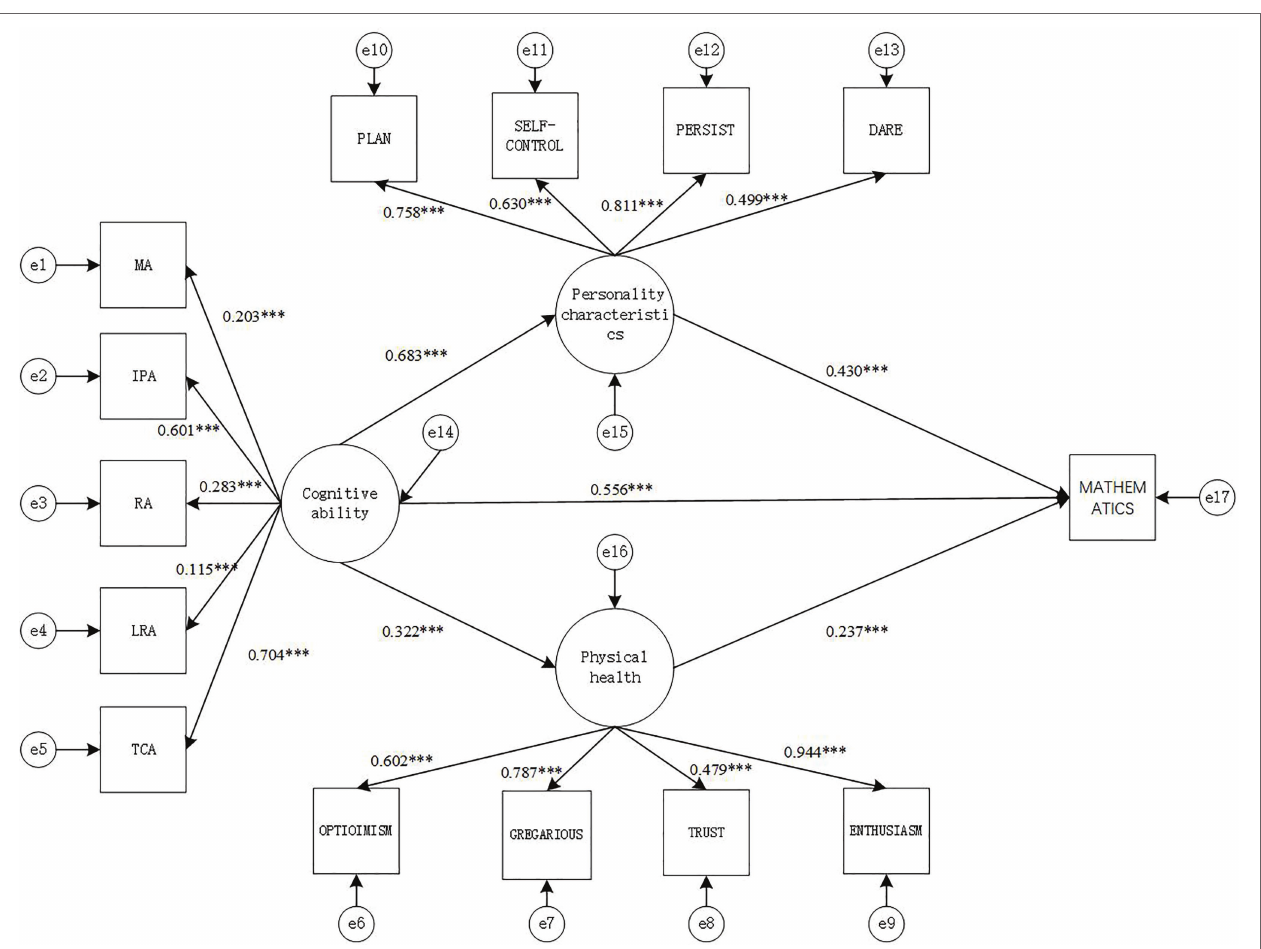
FIGURE 3 | Structural equation intermediary relationship model diagram (model 3). MA, memory ability; IPA, information processing ability; RA, representation ability; LRA, logical reasoning ability; TCA, thinking conversion ability; TS, academic performance. *** p < 0.001.